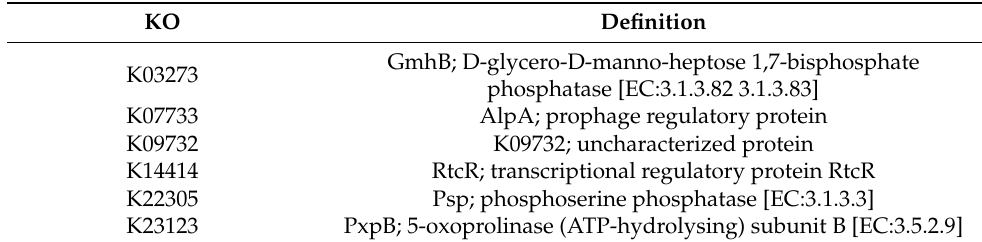
Table 9. KOs that exist in 75% of the Gluconacetobacter entanii strains ( n = 9) and do not exist in more than 25% of Novacetimonas strains ( n =